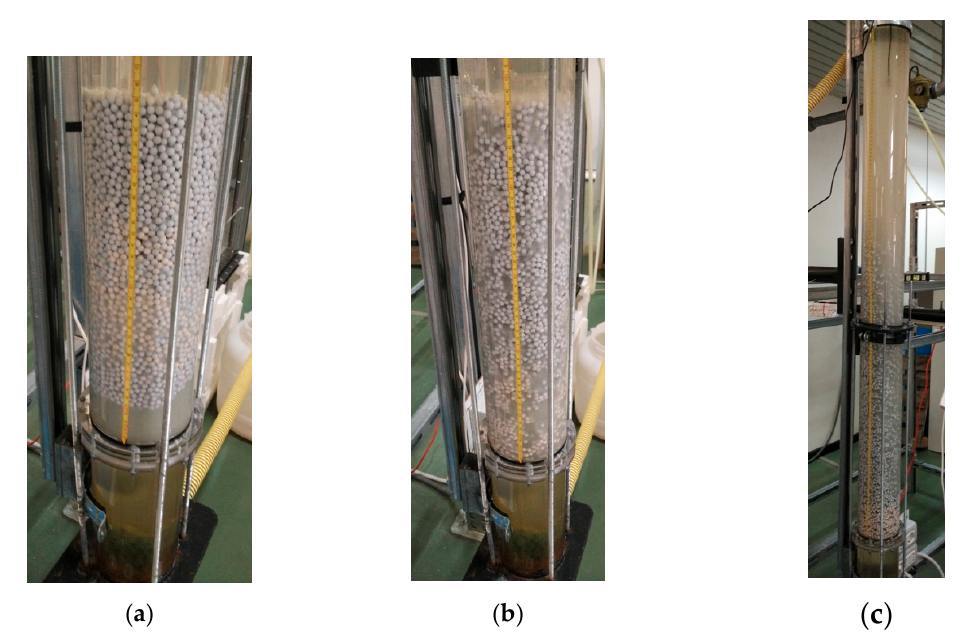
Table 3. Combinations of solids and mixture properties of the investigated systems, with composition, absolute species and species-to-average size and density ratios, inversion voidage predicted by Equation (9) or Equation (12) (Particle Segregation Model, PSM), the experimentally determined inversion voidage and the deviation between the last two. Code GB vol. Fraction 𝒙 𝟏